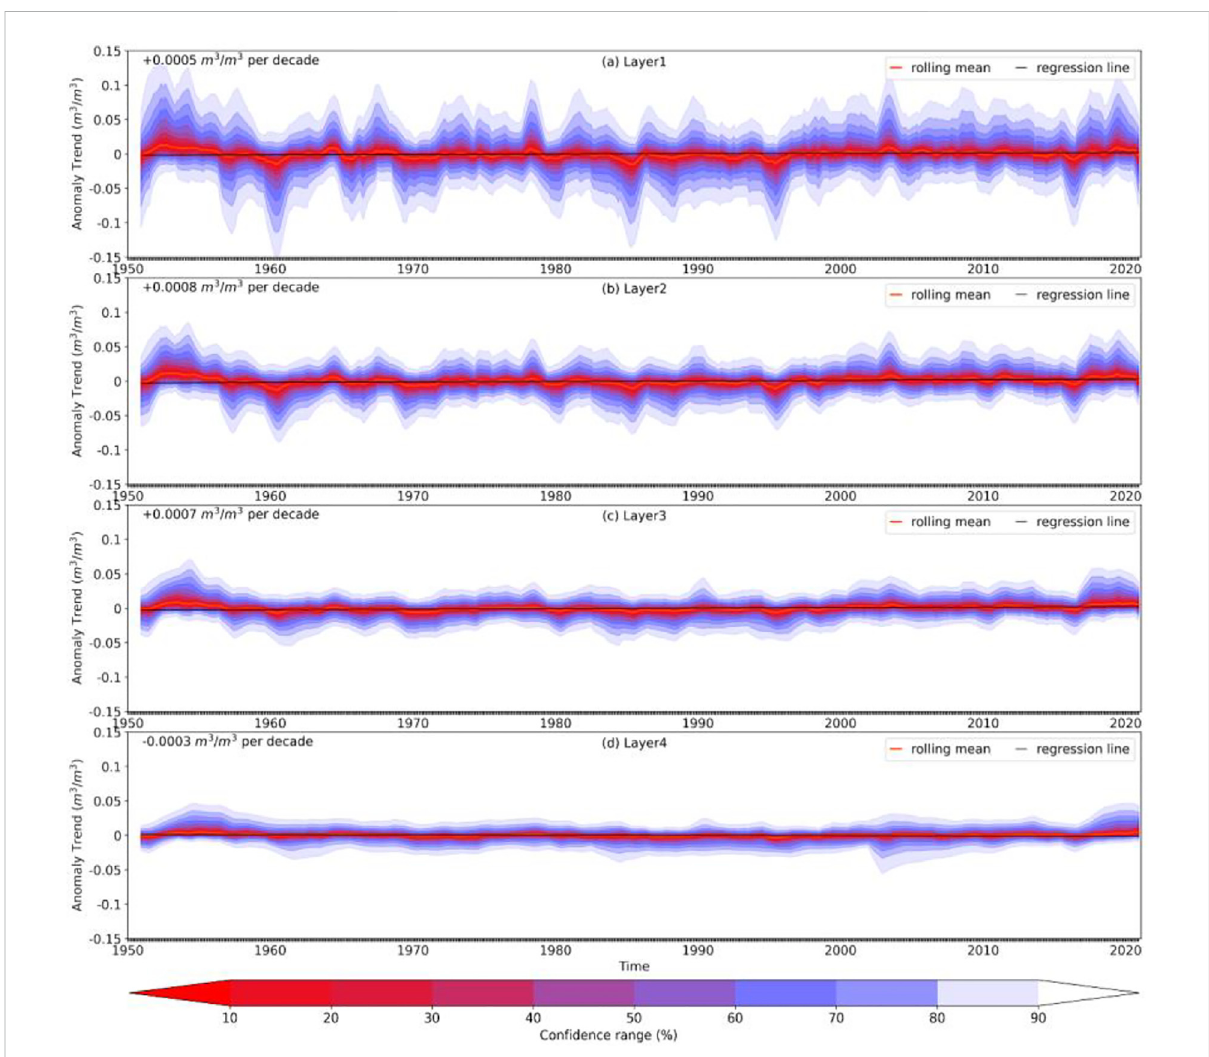
FIGURE 6 The temporal anomaly trend of soil moisture at increasing depth as presented by different layers (A – D) during 1950 – 2020 across the